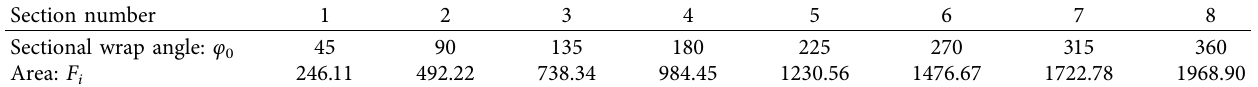
Table 3: Sectional area of cochlear chamber.